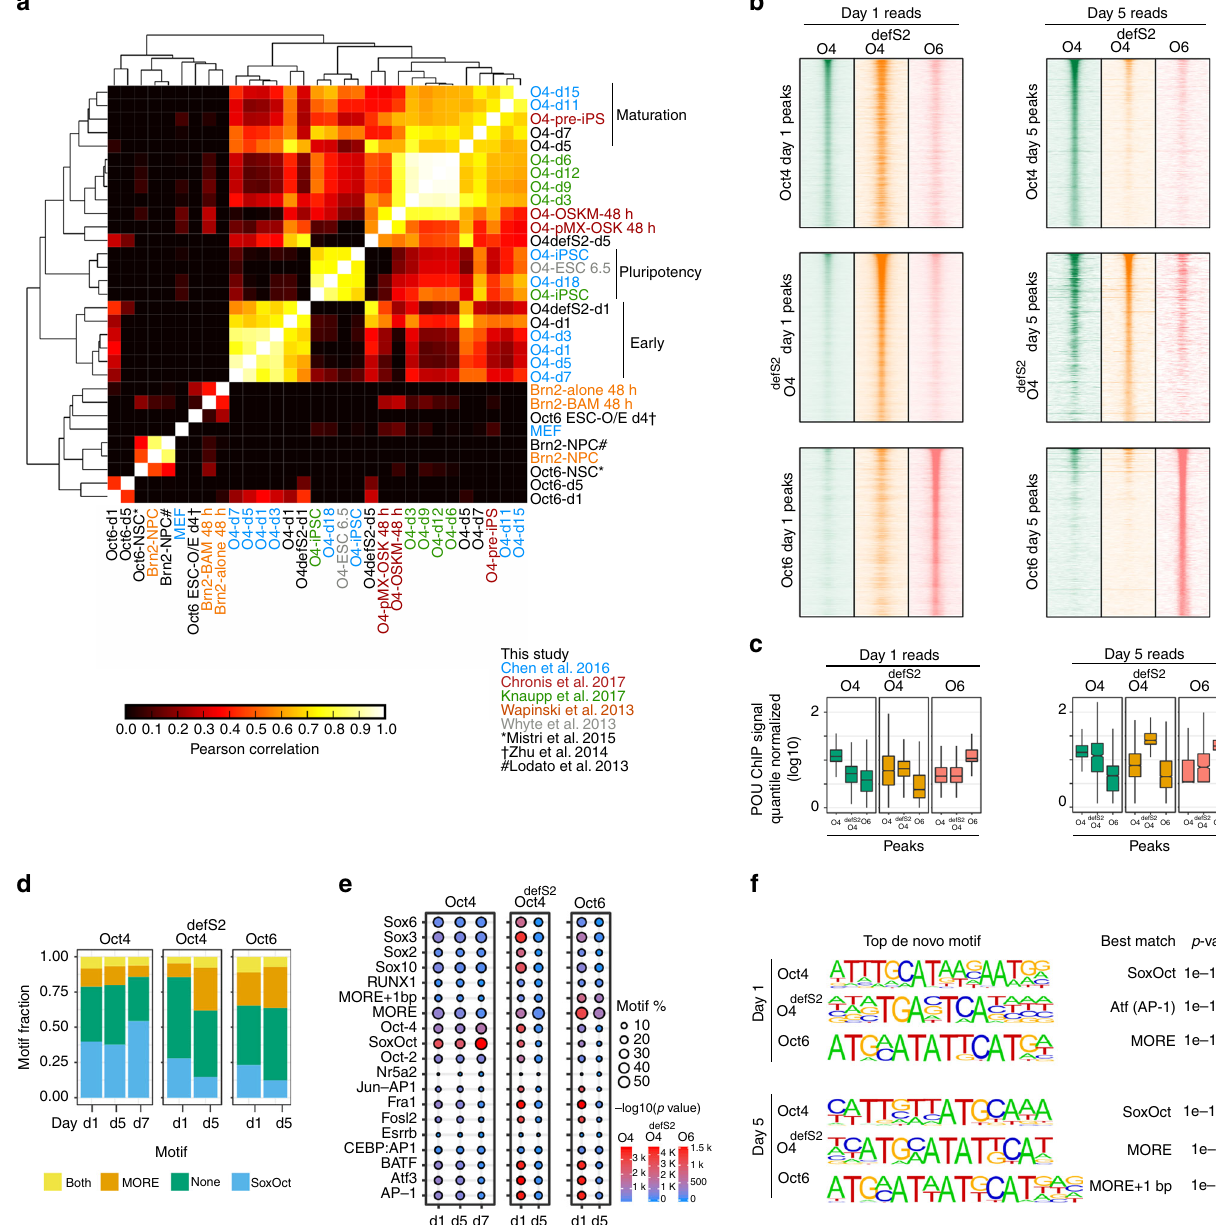
Fig. 3 POU TFs exhibit distinctive binding pro fi les and motif preferences. a Hierarchical clustering of the pairwise correlation coef fi cients (R 2 ) of ChIP-seq signals from Oct4, Oct4 defSox2 and Oct6 ChIP-seq peaks with publically available ChIP-seq datasets for Oct4, Oct6 and Brn2 4 – 6,18,20,22,39,69 . b ChIP-seq signal heatmaps for Oct4 (green), Oct4 defSox2 (orange), and Oct6 (salmon) at days 1 (left panels) and 5 (right panels) centered on ChIP-seq peaks for Oct4 (top panels), Oct4 defSox2 (middle panels) and Oct6 (bottom panels). c Boxplots of quantile normalized ChIP-seq signals at Oct4, Oct4 defSox2 and Oct6 peaks at days 1 and 5 from heatmaps in ( b ). For the boxplots, the midline indicates the median, boxes indicate the upper and lower quartiles and the whiskers indicate 1.5 times interquartile range. d Fraction of binding locations containing MORE (including MORE variant with 1 bp spacer) or SoxOct elements at different reprogramming stages. ‘ Both ’ refers to peaks where motif scanning detected MORE and SoxOct motifs concurrently and ‘ none ’ the absence of either of the two motifs. e Enrichment of selected TF motifs in ChIP-seq peaks at days 1 and 5 for Oct4, Oct4 defSox2 , and Oct6. Size represents fractional occurrences and color gradient the p -value scores. f Top de novo motifs for Oct4, Oct4 defSox2 and Oct6 at days 1 and 5. In the HOMER database the MORE motif is designated as Pit1 and MORE + 1 bp as Pit1 + 1bp